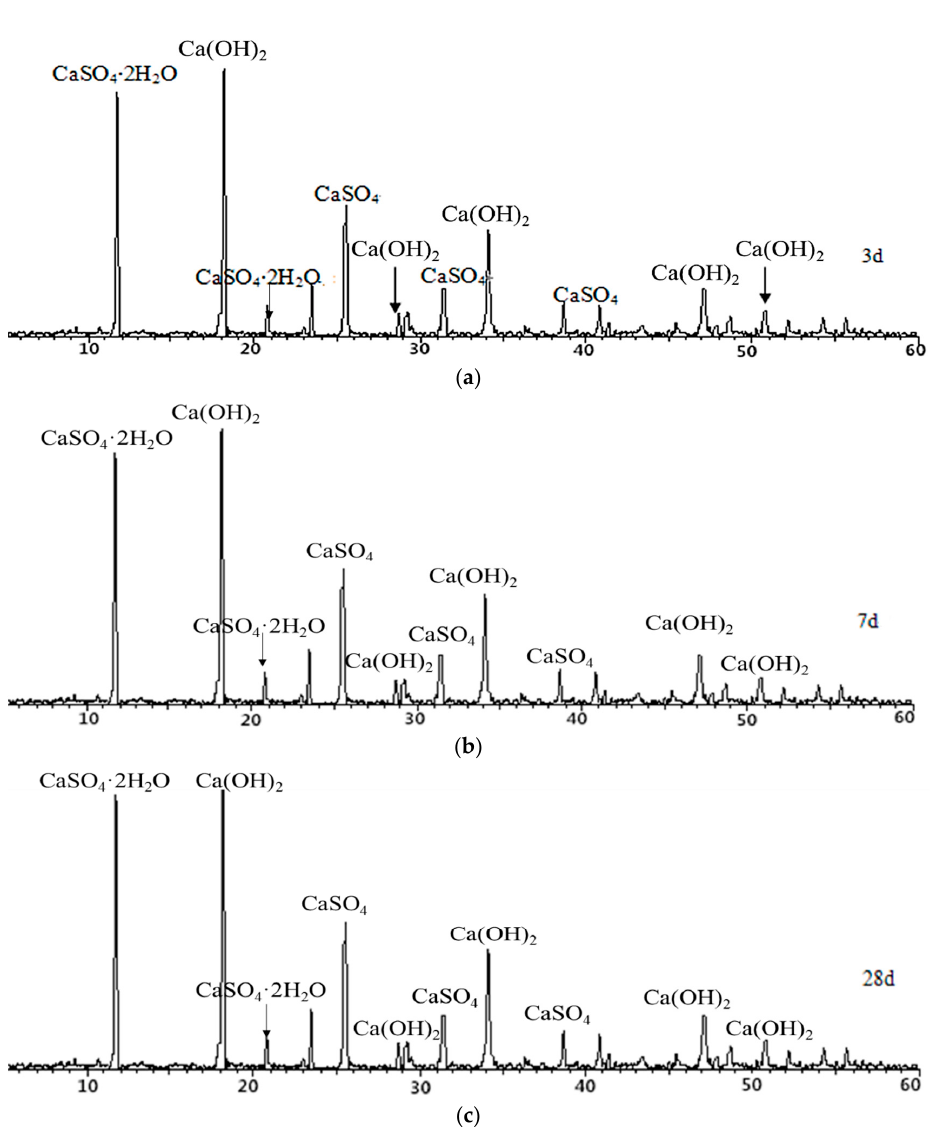
Figure 9. XRD maps of petroleum coke residue paste at ( a ) 3d, ( b ) 7d, and ( c ) 28d.